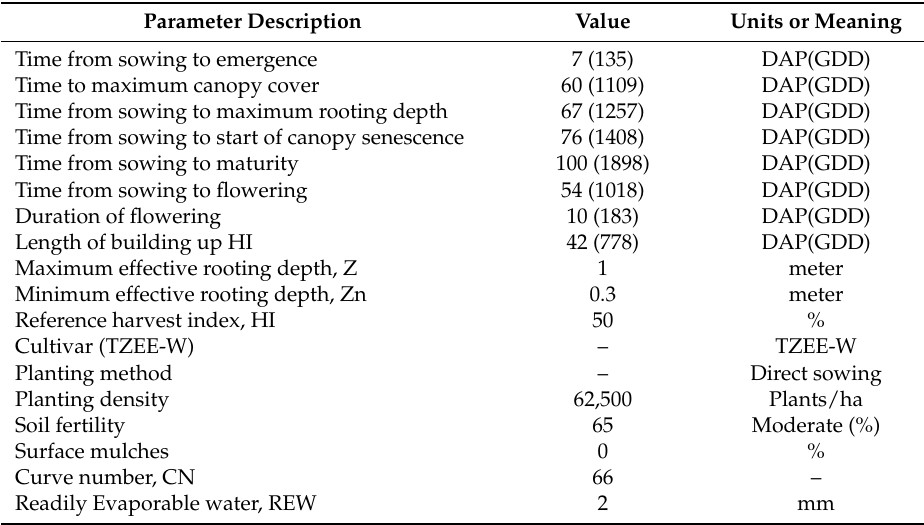
Table 3. Non-conservative parameters adjusted and agronomic information for Dapaong, Togo.